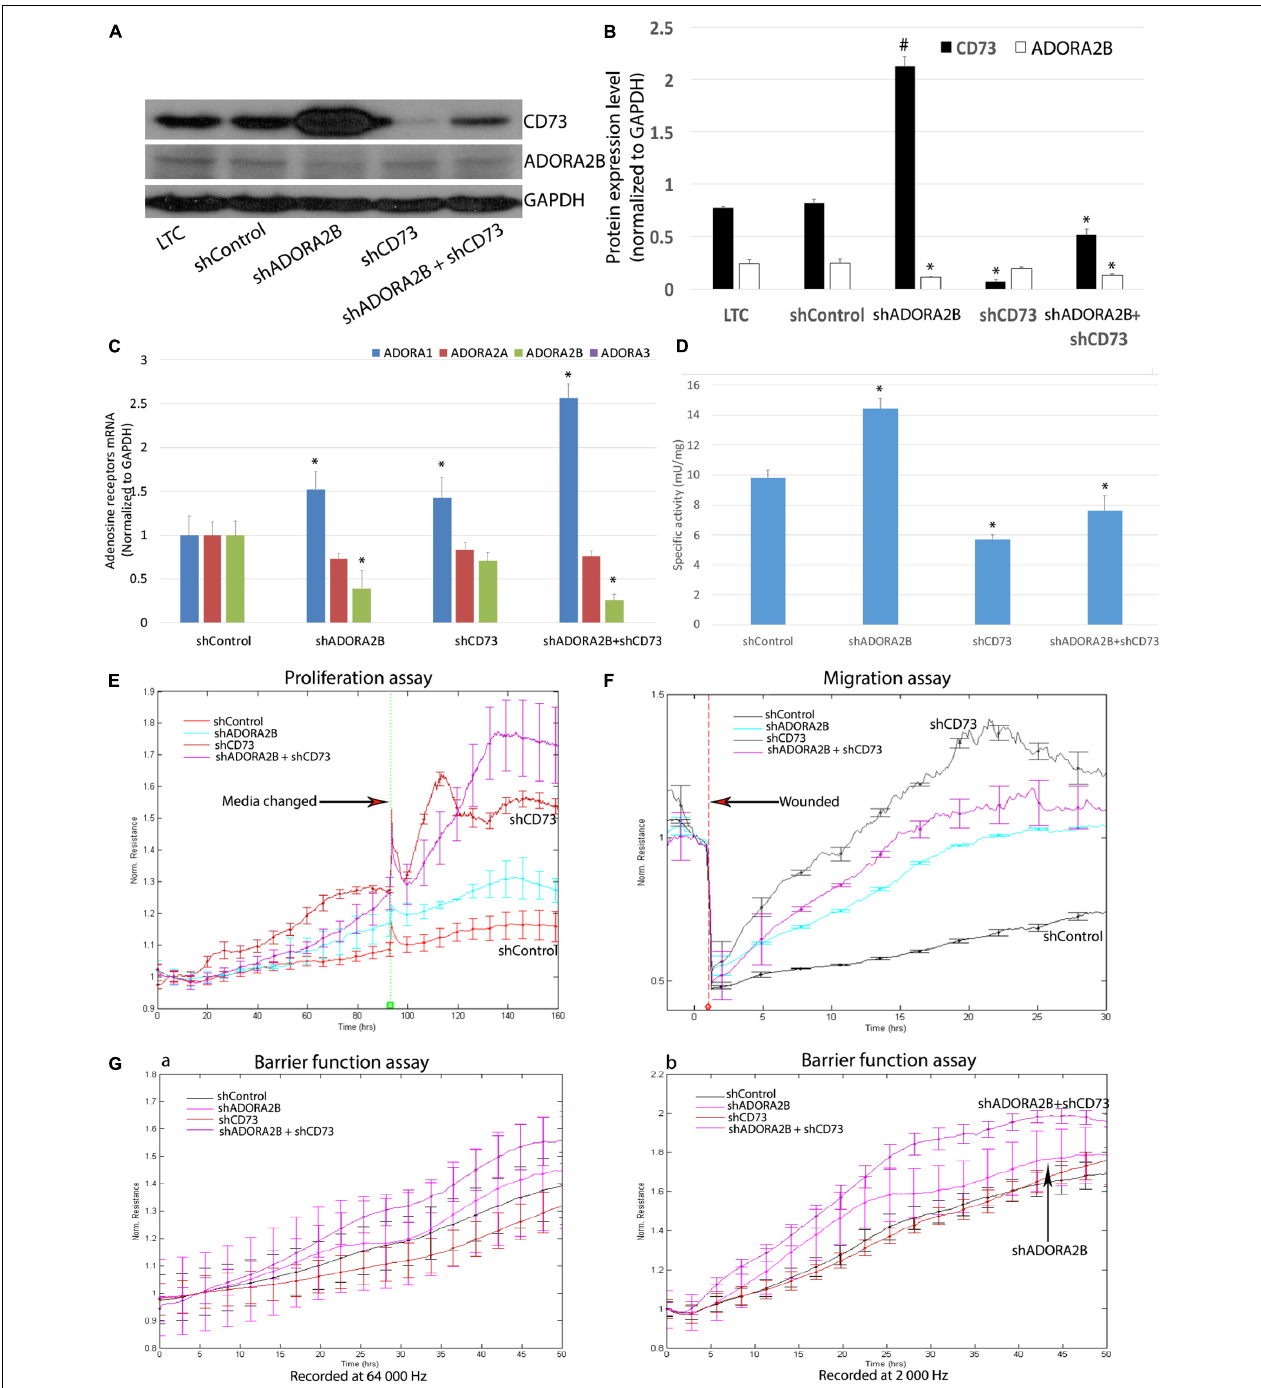
FIGURE 4 | (A) Efficient ADORA2B and/or CD73 knock down in LTC. (B) Normalized densitometry analysis of ADORA2B and CD73. Values are mean ± SE, ∗ indicated p < 0.05, # indicated that CD73 protein expression level significantly increased, p < 0.05. (C) Transcript levels of ADORA1, ADORA2A, ADORA2B, and ADORA3 in Nuli-1 cells. ∗ indicates significance value P < 0.05 compared with shControl group. The transcript level of ADORA3 was not detected in Nuli-1 cells. (D) CD73 enzyme activity in Nuli-1 cells. ∗ indicates significance value P < 0.05 compared with shControl group. (E) Targeting both ADORA2B and CD73 ameliorates long-term CSE impaired cell proliferation. Media were changed after 96 h. Signals were recorded at 4,000 Hz. Each condition was conducted in triplicate. Statistically differences observed after 80 h ( P < 0.05). (F) Targeting both ADORA2B and CD73 ameliorates long-term CSE impaired cell migration. The resistances were measured at 4,000 Hz. Each condition was conducted in triplicate. Statistically differences observed after 6 h ( P < 0.05). (G) Targeting both ADORA2B and CD73 ameliorates long-term CSE impaired cell barrier function. a. Resistances were recorded at 64,000 Hz; b. Resistances were recorded at 2,000 Hz. The resistances were measured simultaneously. Each condition was conducted in triplicate. Statistically differences observed after 27 h ( P < 0.05).